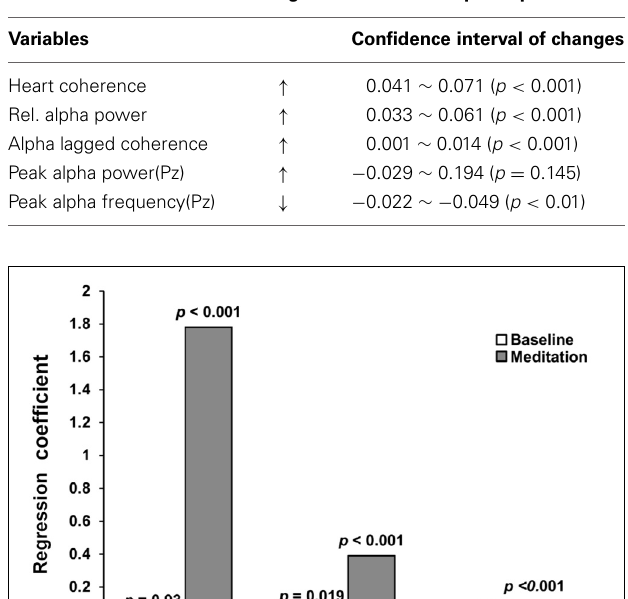
Table 1 | Confidence intervals (95%) for changes in measured variables from baseline to during meditation for all participants.